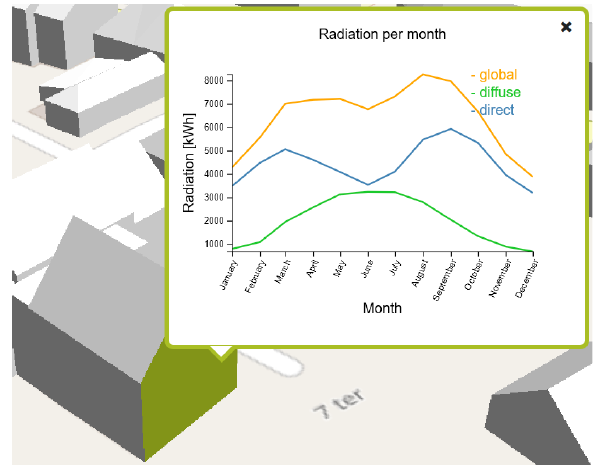
Figure 4. The interactive timeseries representation of monthly irradiation values of a building. Screenshot taken from (virtualcityMAP,